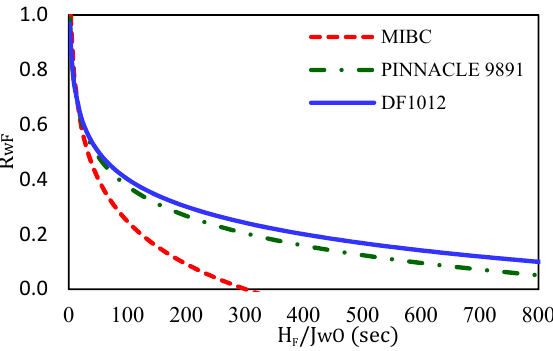
Figure 8. Fitted models for the recovery of water as a function of liquid retention time in the froth for different frothers.